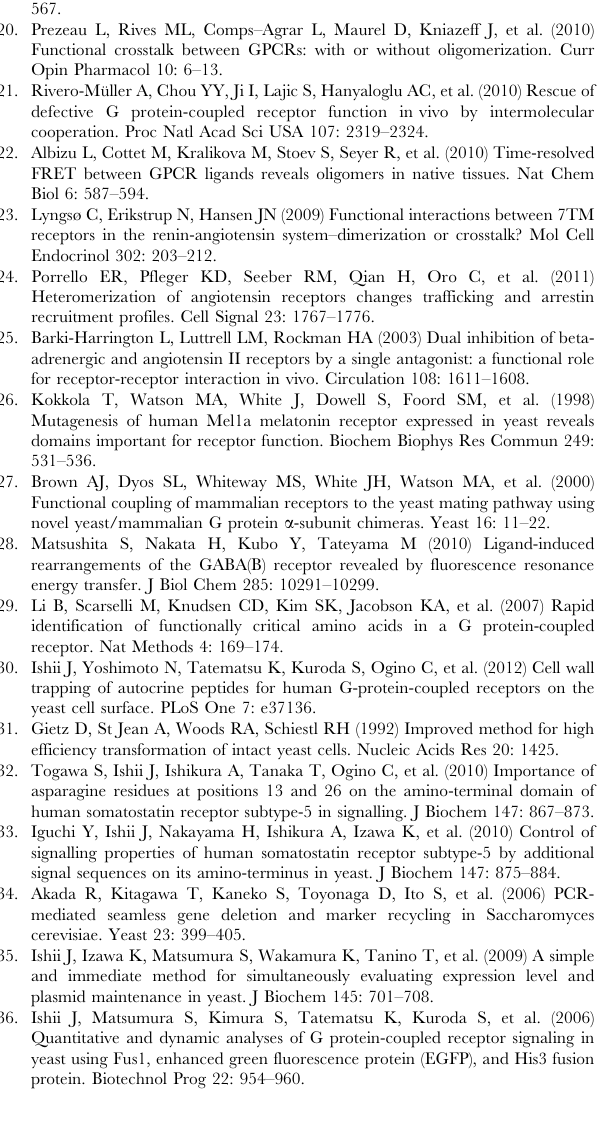
Figure S5 Detection of homo- and hetero-dimerization of human GABA B1a receptor with GABA B2 receptor in NMY63 strain. Quantitative b -galactosidase assay. NMY63 yeast strain was transformed with plasmids expressing indicated protein pairs. Error bars represent the standard deviations ( n =3). The control prey plasmid was pPR3-C mock vector. (TIF) Table S1 List of oligonucleotides. (PDF) Table S2 List of plasmids. (PDF)